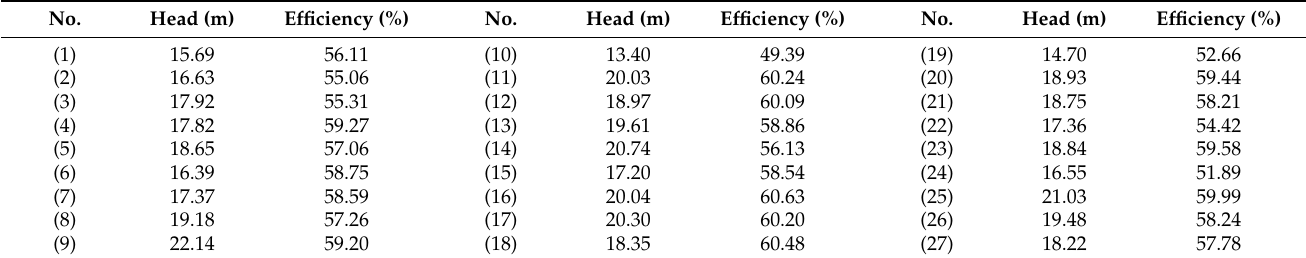
Table 7. Simulated performances of pump orthogonal schemes.